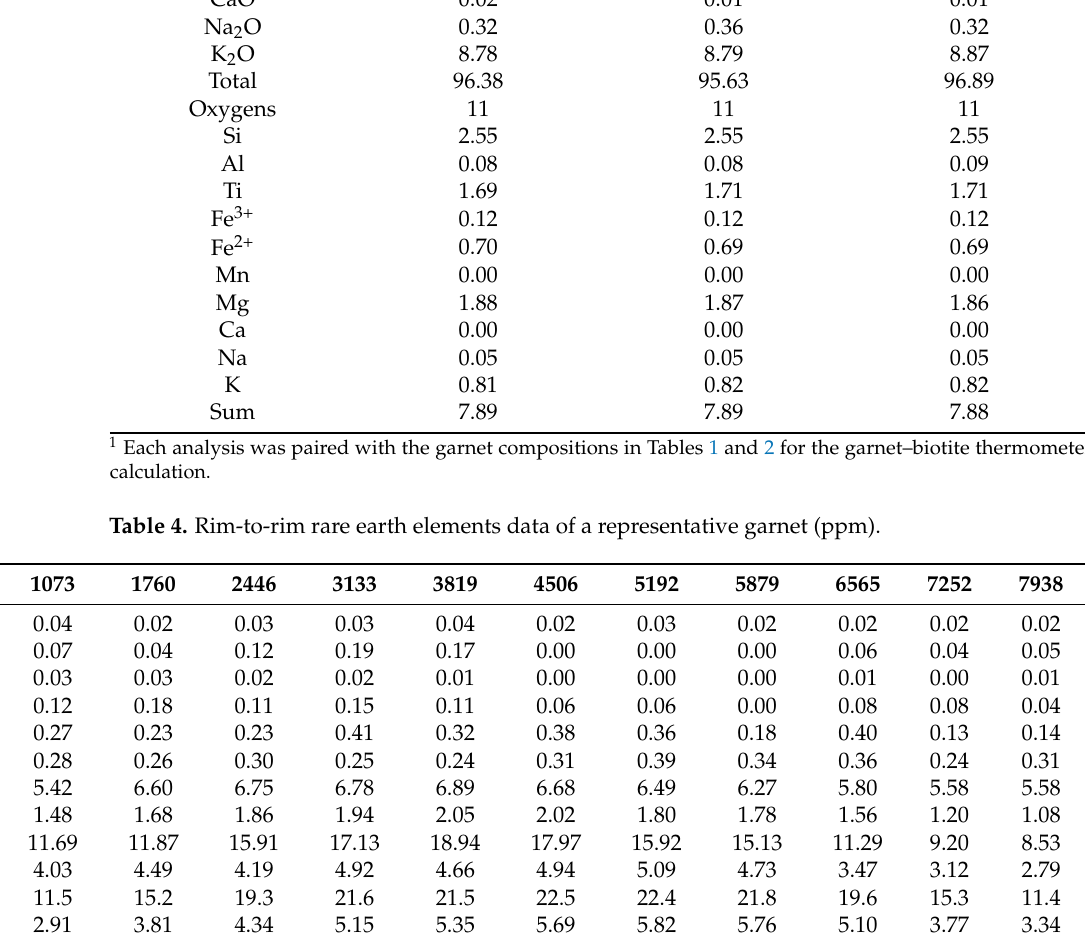
Figure 3. The parent/daughter ratios of Lu/Hf for the garnets are 8.2–9.9. These high parent-to-daughter (p/d) ratios suggest minor contamination of low p/d inclusions, for example, zircon (Hf), for these garnets. Seven garnet fractions combined with the whole- rock aliquot yield two-point isochron dates from 479 ± 3 Ma to 463 ± 3 Ma (Figure 3). 556 ± 18 Ma (MSWD = 0.32, p ( χ 2 ) = 0.9; Figure 4), which is statistically precise yet